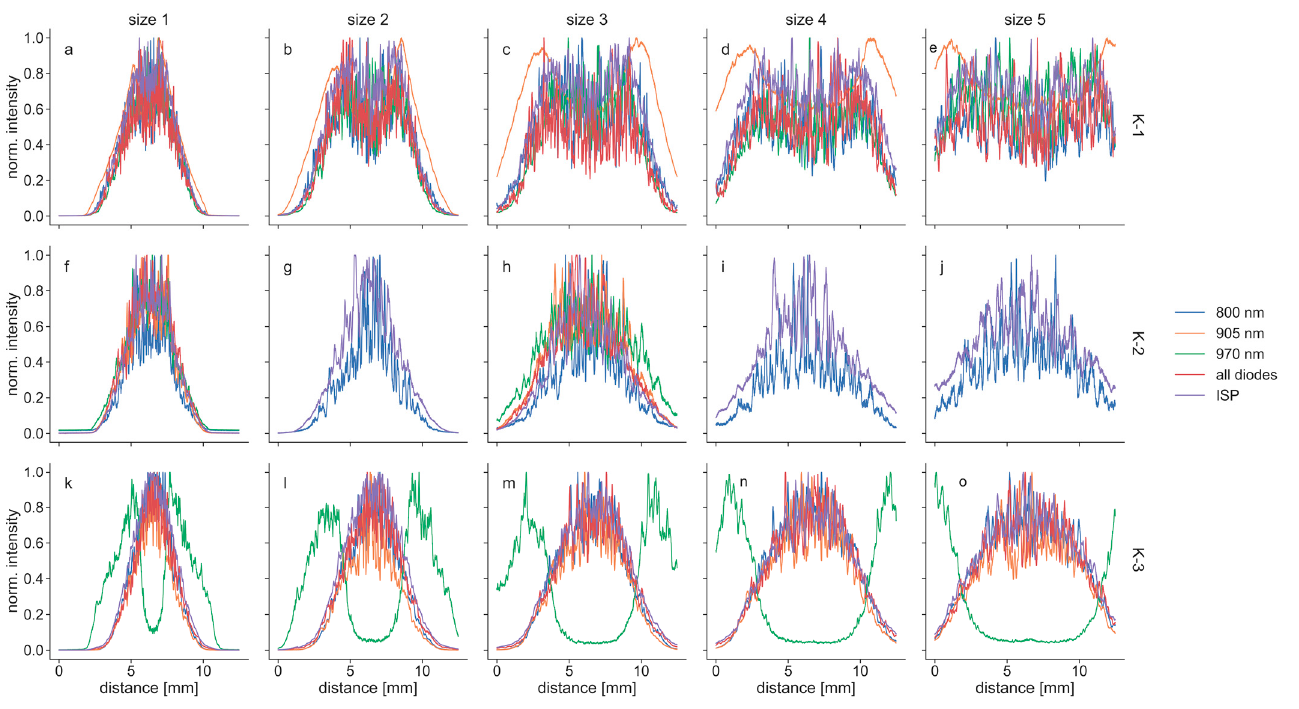
Figure 9. Beam profiles for the three K-lasers along a horizontal line across the intensity distributions: ( a – e ) K-1; ( f – j ) K-2; ( k – o ) K-3. The profiles were extracted from camera recordings of the individual diodes (800 nm, 905 nm, 970 nm), all diodes simultaneously and the K-lasers’ intense-super-pulse (ISP) mode. The sizes 1–5 were set at the zoom objective of each device. For K-2, four modes (800 nm, 905 nm, 970 nm, all diodes) were only recorded for sizes 1 and 3. All signals were normalized to their maximum intensity.